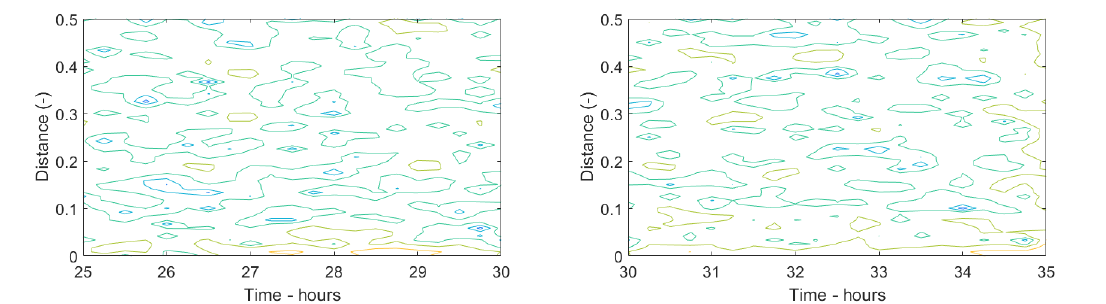
Figure 9. Contour plot of power output for constant wind speed conditions. Left: MOOP optimization. Right: Global optimization. The maximum value (red) corresponds to a 90–100% power extraction, while the lowest value (blue) corresponds to 0–10% power